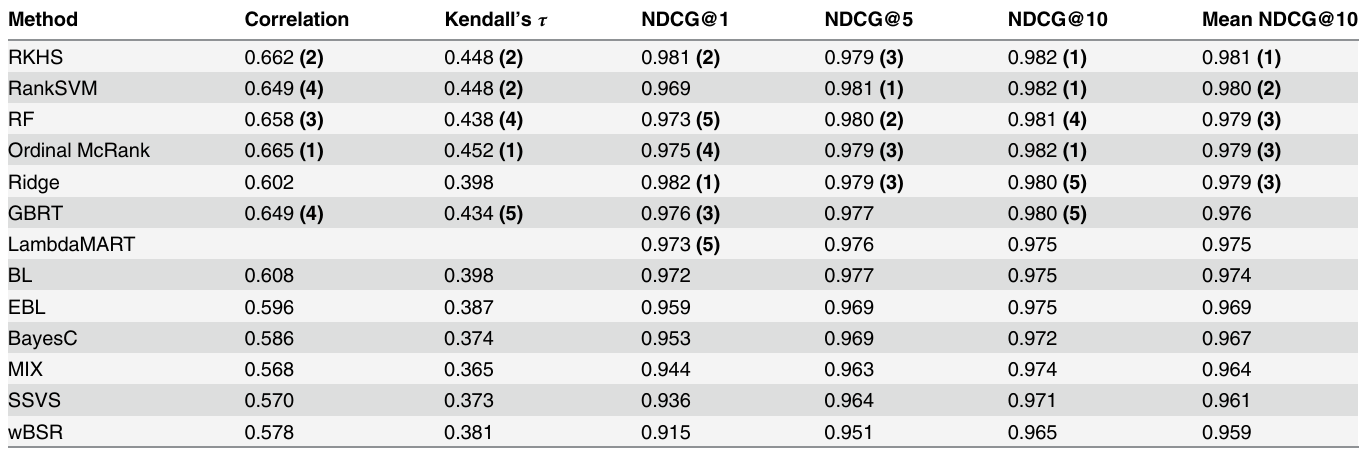
Table 7. Results on the Wheat (Pérez-Rodríguez) dataset, averaged across 2 traits.